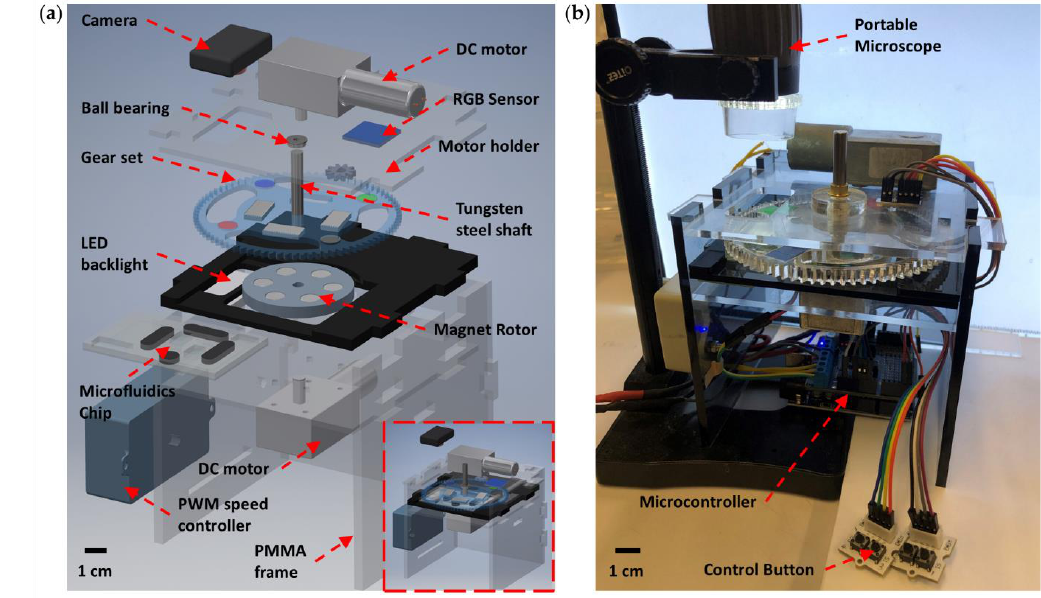
Figure 1. Schematic illustration of the self-contained microfluidics platform enabled by magnetorheological elastomer (MRE). ( a ) Exploded schematic representation of the integrated platform. The lower inset shows the assembled model of the system. ( b ) Actual image of the assembled system integrated with a portable digital microscope.